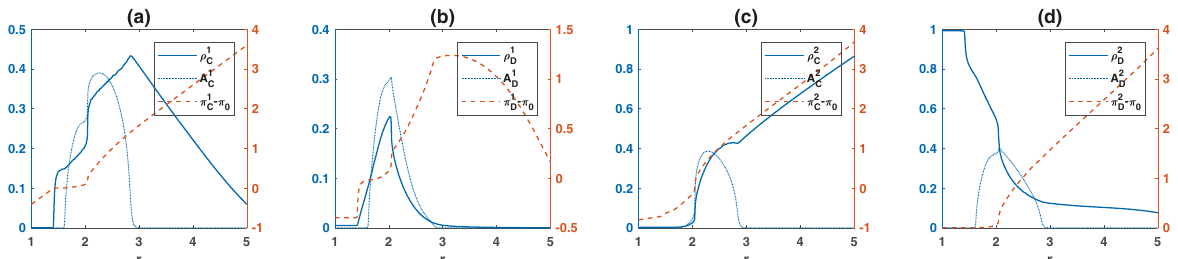
Fig. 1 The frequency, game payoffs, and the amplitude of fl uctuations for different strategies. The frequency (solid blue), game payoffs (dashed red), and amplitude of fl uctuations (dotted blue) of costly cooperators ( a ), costly defectors ( b ), non-costly cooperators ( c ), and non-costly defectors ( d ), as a function of the enhancement factor, r . As r increases, above a fi rst threshold ( r * = 1 + c g ), cooperation in the costly institution evolves, and above a second threshold (approximately r = 2) cooperation in both the costly and the free institutions evolves. For medium r , the system shows periodic fl uctuations. Parameter values: g = 5, nu = 10 − 3 , π 0 = 2, c g = 0.398. The replicator dynamic, derived in the Methods Section, is solved for 9000 time steps, and the time averages are taken over the last 2000 time steps.